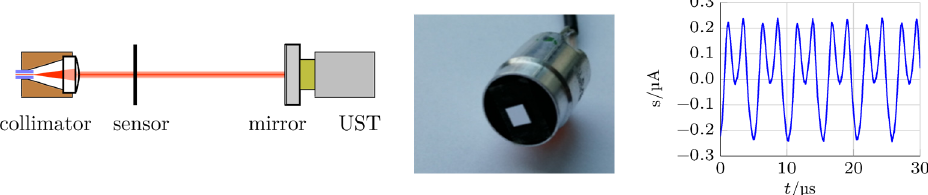
Figure 3. Experimental set-up for the phase-modulated standing wave interferometer ( left ). The measuring mirror is modulated by an ultrasonic transducer (UST, middle ), applying the correct stroke to obtain quadrature signals. Moving either the sensor or the mirror along the optical axis will result in an alternating sensor signal (cid:1871) , suitable for length measurements ( right